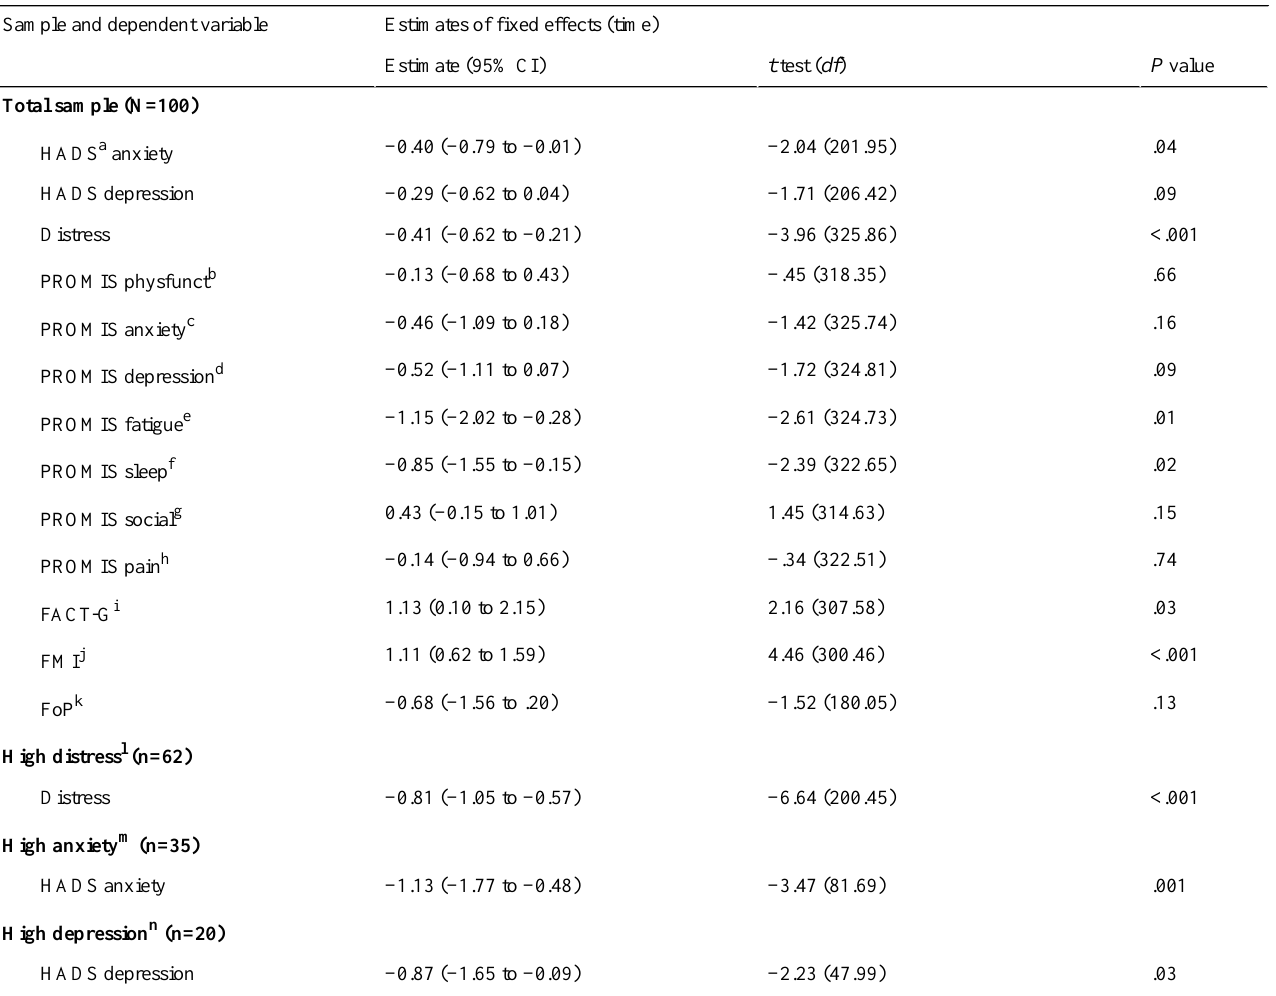
Table 3. Linear mixed models: estimates of fixed effect of time on health outcomes from baseline to week 20. Estimates of fixed effects (time)Sample and dependent